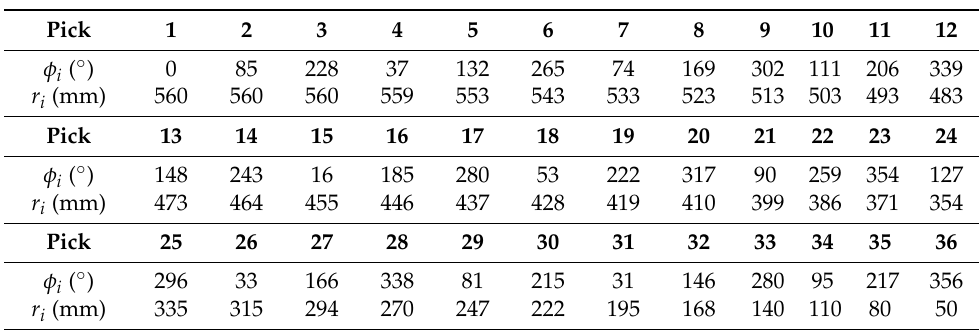
Table 2. Information of cutting pick.